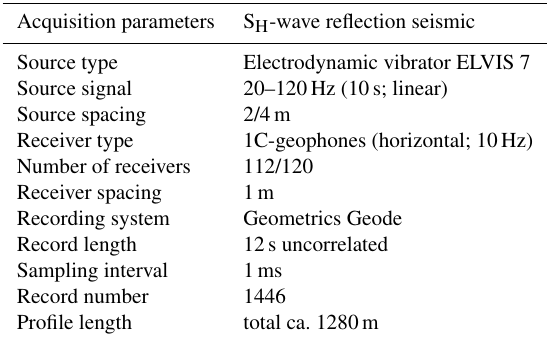
Table A1. Acquisition parameters of the S H -wave reflection- seismic surveys.